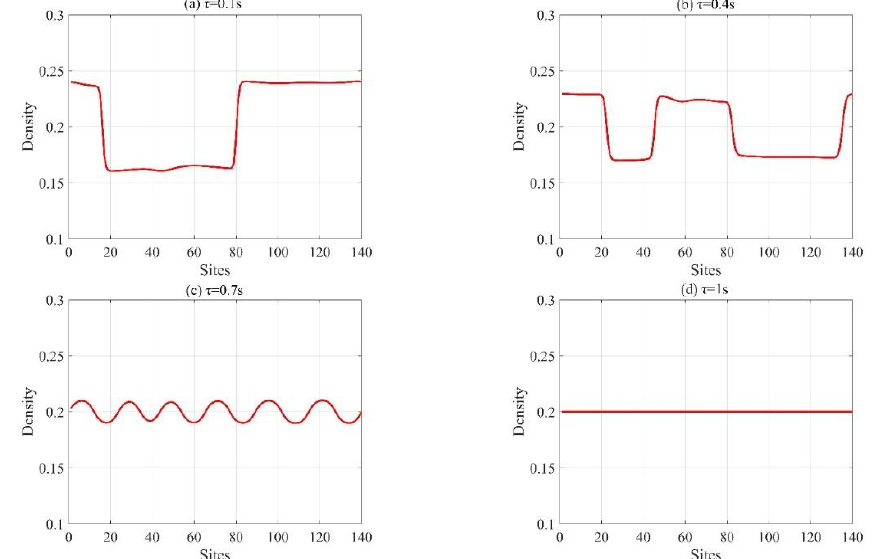
Figure 8. Density profile at t = 10,300 s corresponding to Figure 7.